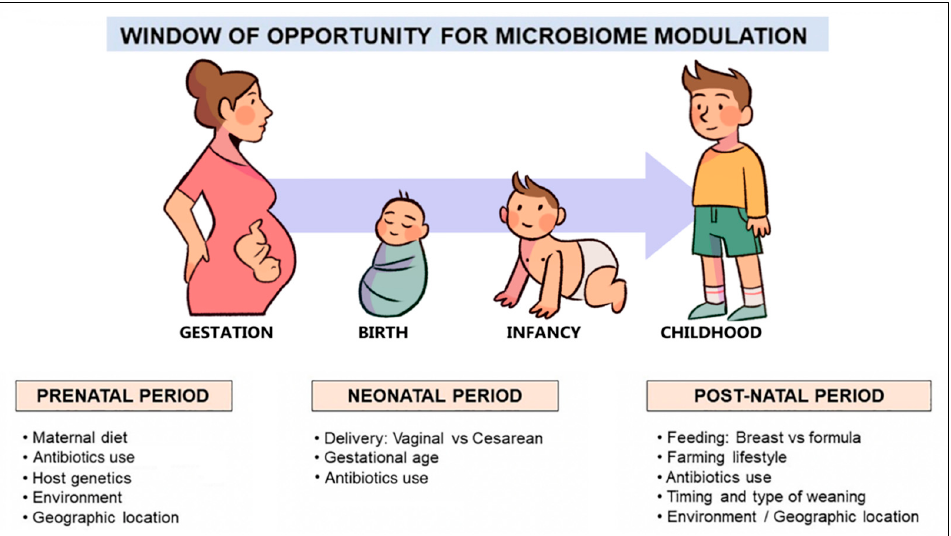
Figure 2. Factors shaping the human microbiome development in early life.